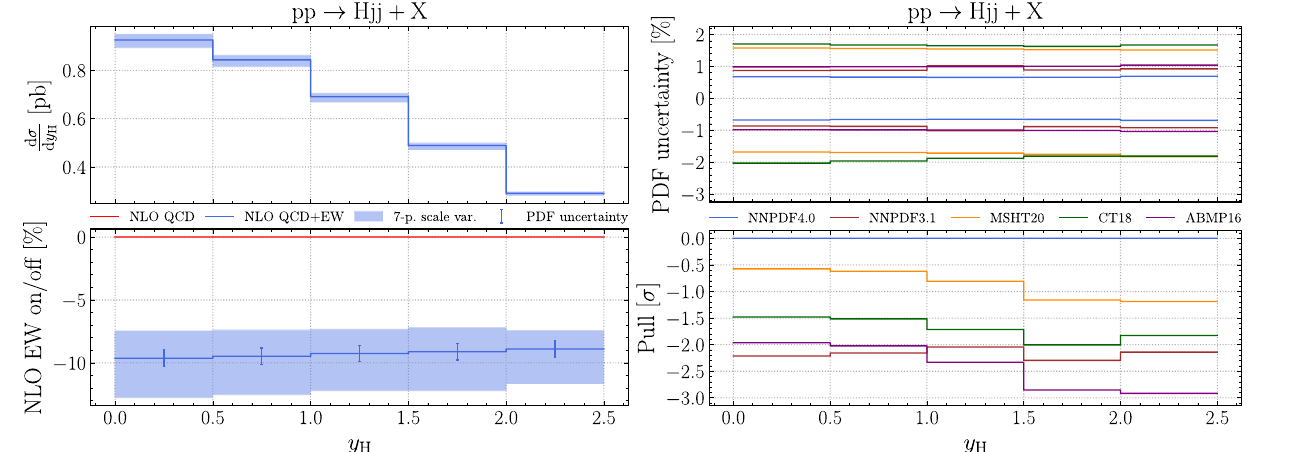
Fig. 73 Same as Fig. 63 for pp → Hjj +